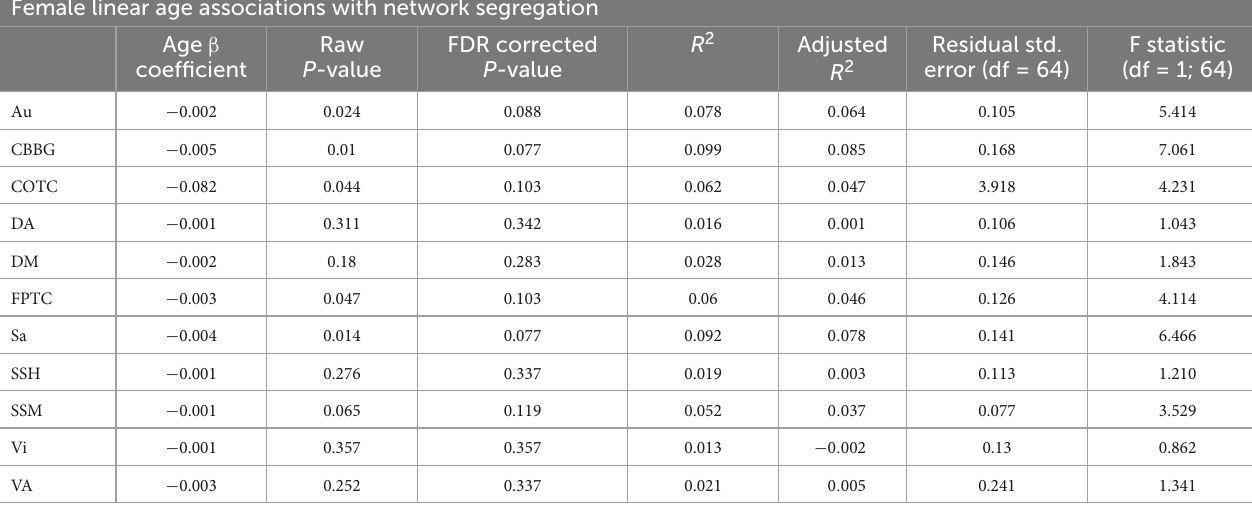
TABLE 6 This table exhibits results from linear regressions for age and network segregation in females. Female linear age associations with network segregation